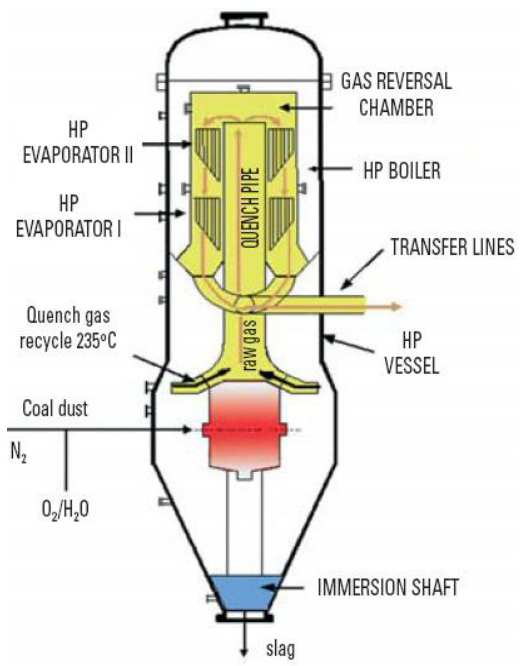
Figure 17. PRENFLO™